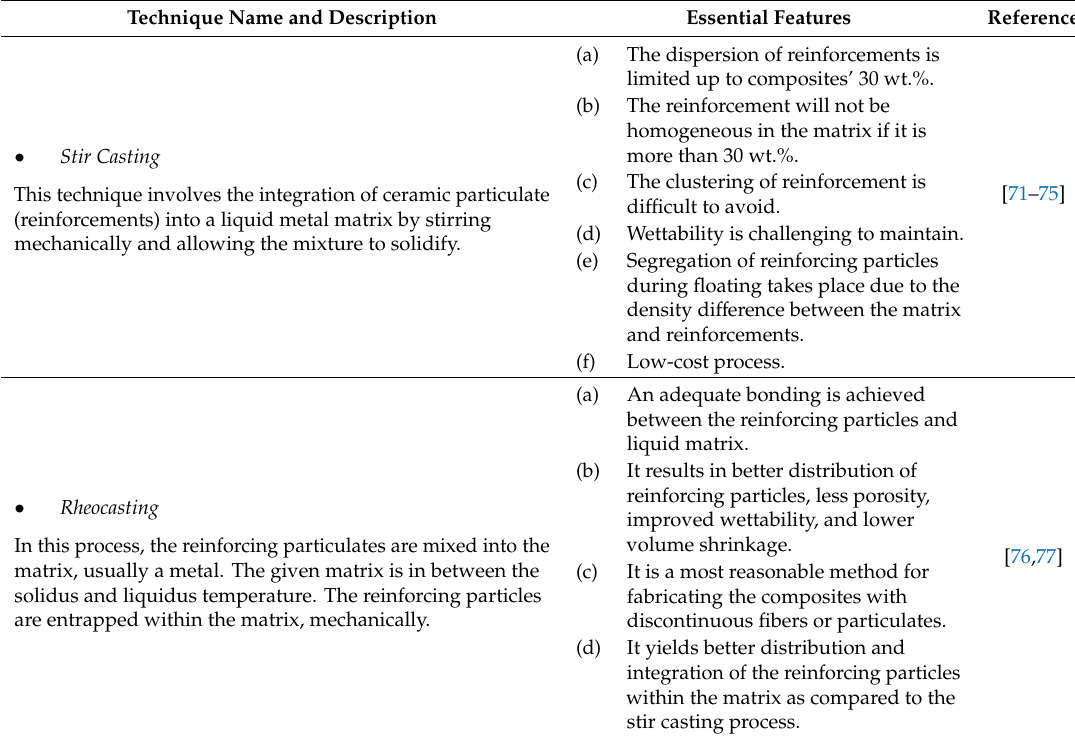
Table 3. Mixing techniques for MMCs.